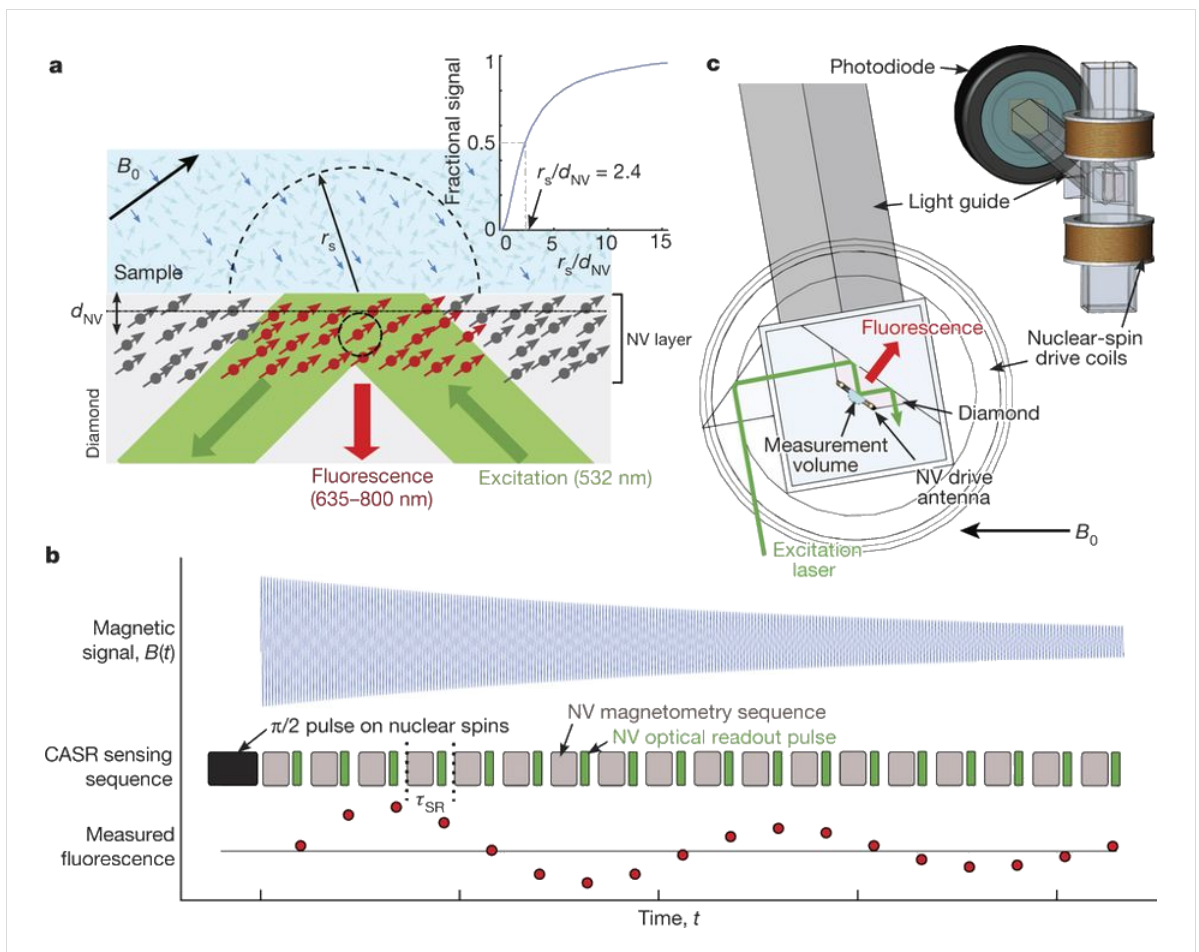
Figure 6: NV-ensemble sensor for coherently averaged synchronized readout (CASR) NMR. Image reprinted with permission from [82], copyright 2018, Springer Nature Publishing. (a) NV-ensemble sensor based on an NV center surface layer on a diamond chip, probed by a green laser. Ther- mally polarized nuclear spins are NMR detected from the sample. (b) CASR detection of an NMR FNP signal. Top row: thermally polarized spin precession at frequency f causes oscillations in the magnetic field. Middle row: CASR protocol made of optical NV spin-state readouts blocks repeated at the synchronized readout cycle period intertwined with blocks of identical NV AC magnetometry pulse sequences with central frequency. (c) Probe geometry: a cuvette holds the sample and the diamond chip, above and below are the cylindrical coils driving the nuclear spins, while a wire antenna drives the NV centers. A light guide collects the spin-state-dependent fluorescence from the NV to bring it to a photodiode, while an electro- magnet supplies the magnetic bias